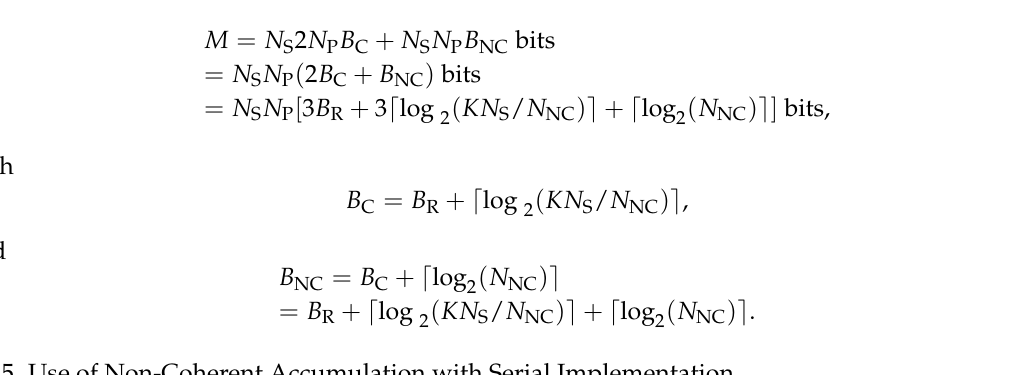
Figure 8. Implementation of a pilot channel acquisition, with non-coherent accumulation, in a parallel way (timing diagram available in Figure 5).